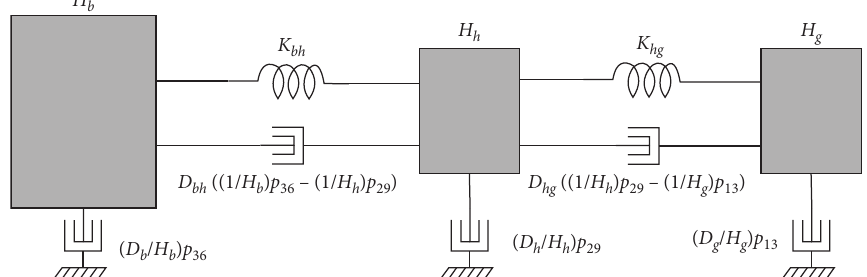
Figure 4: Schematic diagram of the three-mass equivalent model of a wind turbine, considering resistance quadratic in the dissipation elements.